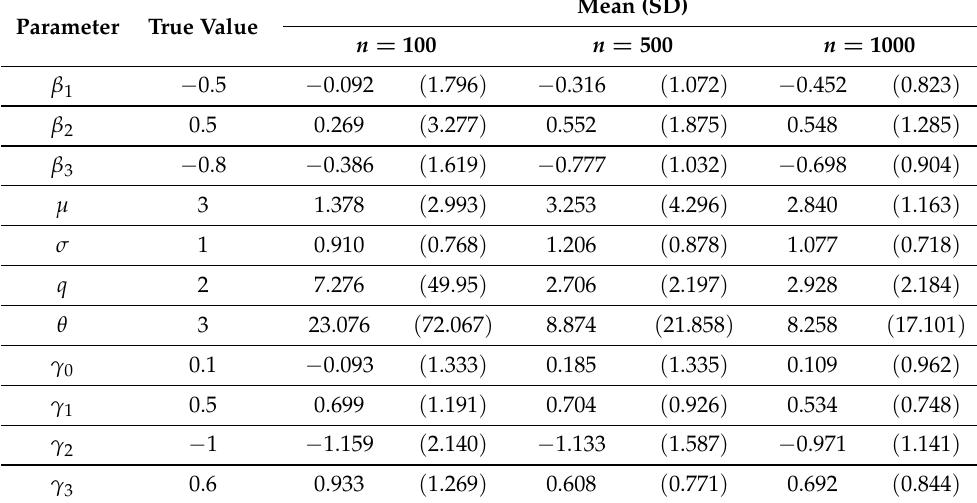
Table 3. Means and standard deviations (SD) of estimate values in setting